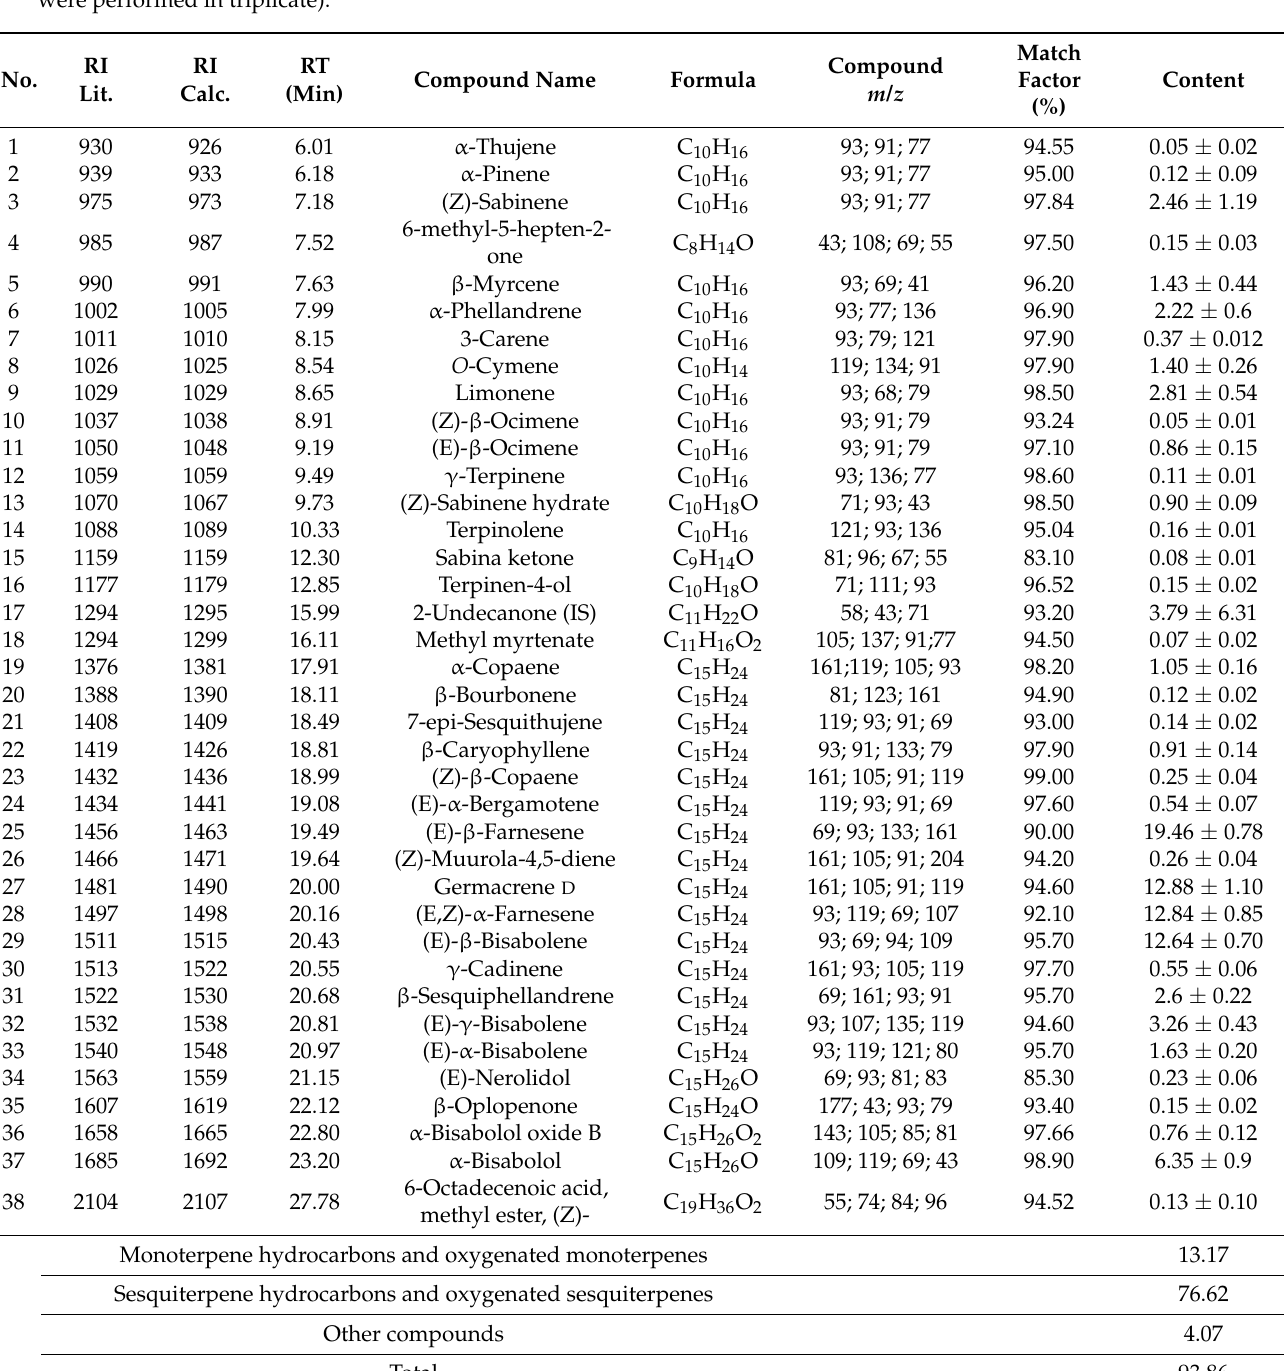
the main compounds identified in the E. senticosus fruits. Table 2. Percentage of volatile compounds identified by HS–SPME/GC–MS in E. senticosus fruits (% ± SD) (RT—retention time, RI calc—retention index, calculated, RI lit—retention index, literature. Internal standard—2-undecanone. All analyses were performed in